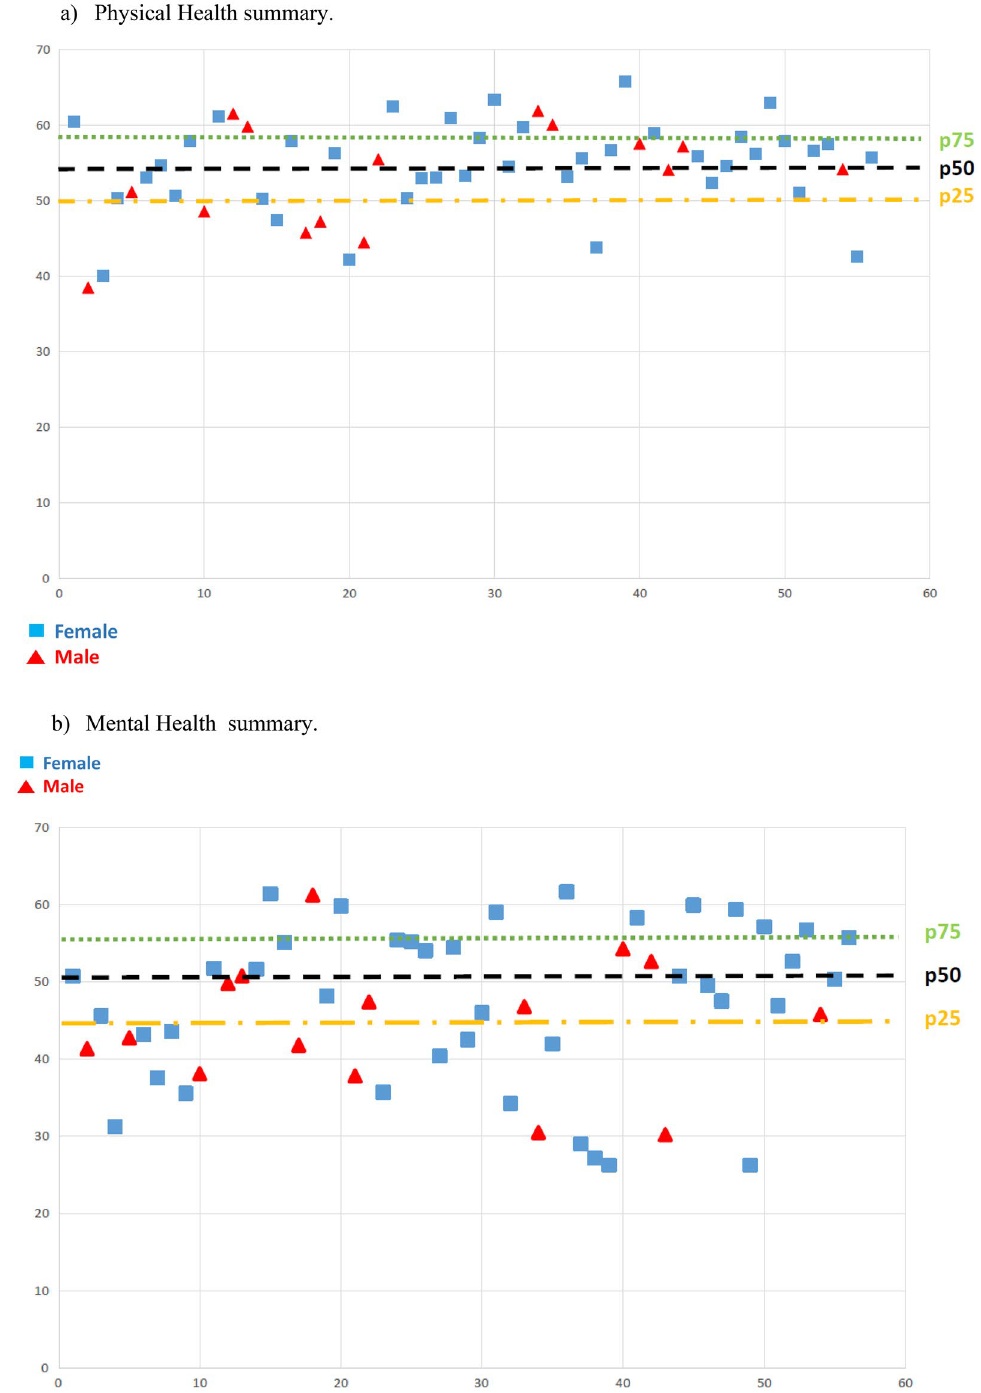
Figure 1. ( a ) Physical health summary. ( b ) Mental health